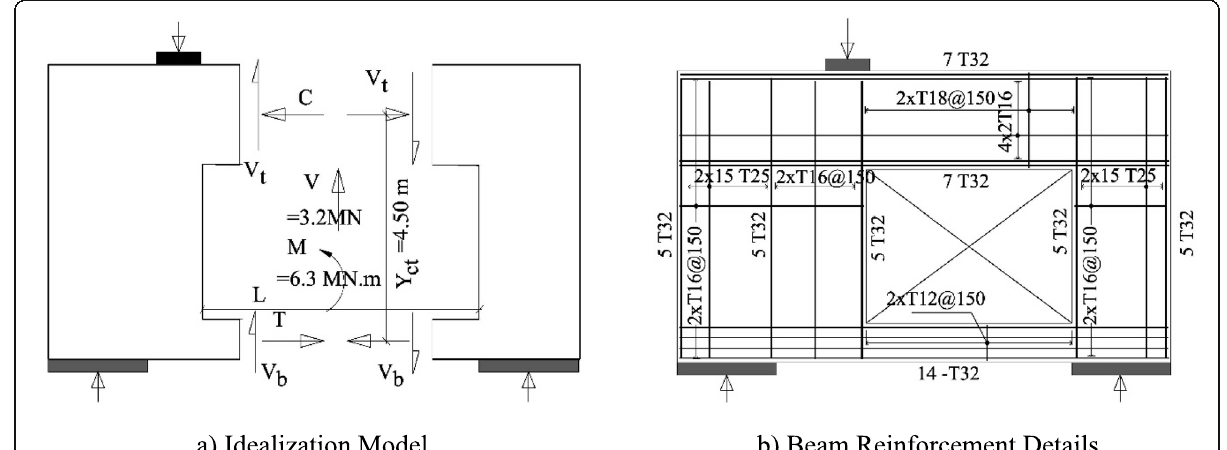
Fig. 3 Mansur [16] model. a Idealization model. b Beam reinforcement